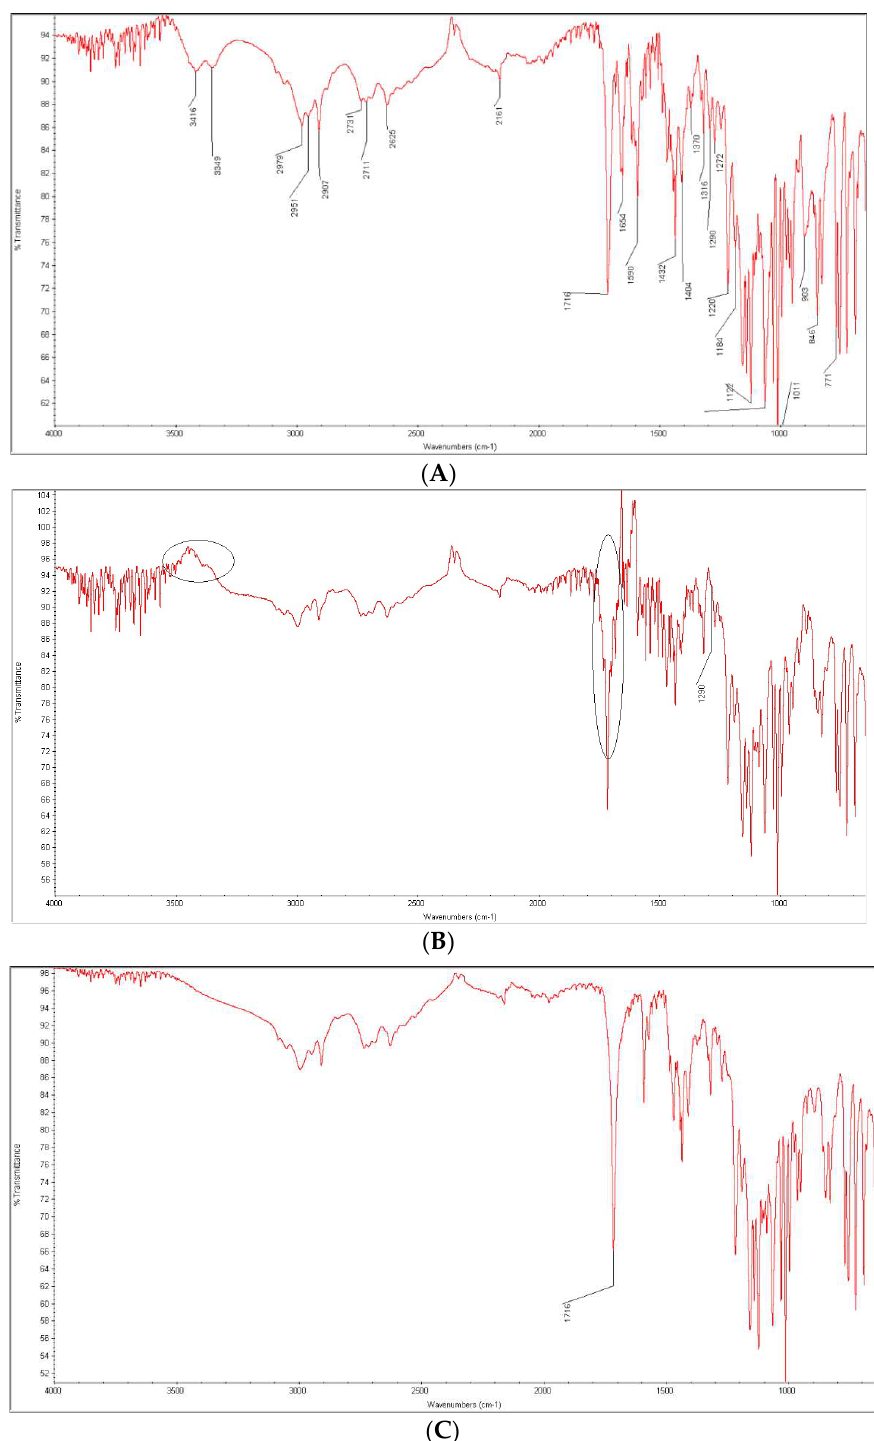
Figure 15. FT-IR spectra of bepotastine (BEPO) as a bulk ( A ) and in the mixtures with polyvinyl alcohol (PVA): non-stressed mixture ( B ) and the mixture stressed under UV/VIS light ( C ). After mixing DIPH and CA, the most characteristic bands of the drug including